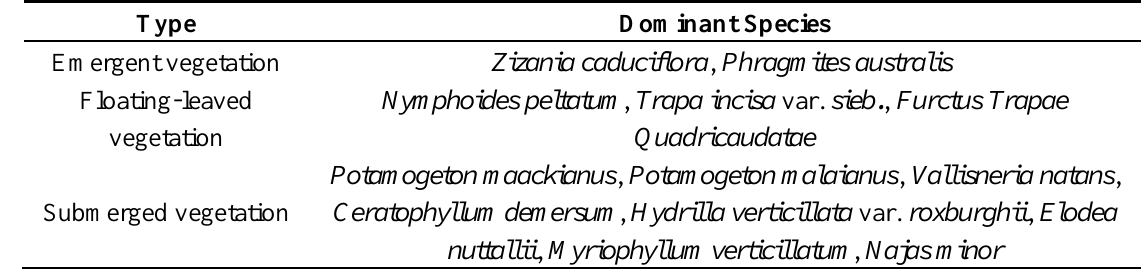
Table 1. Dominant species of aquatic vegetation in Lake